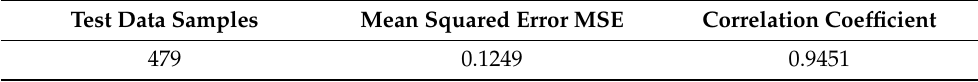
Table 2. Test data results of RNN–LSTM